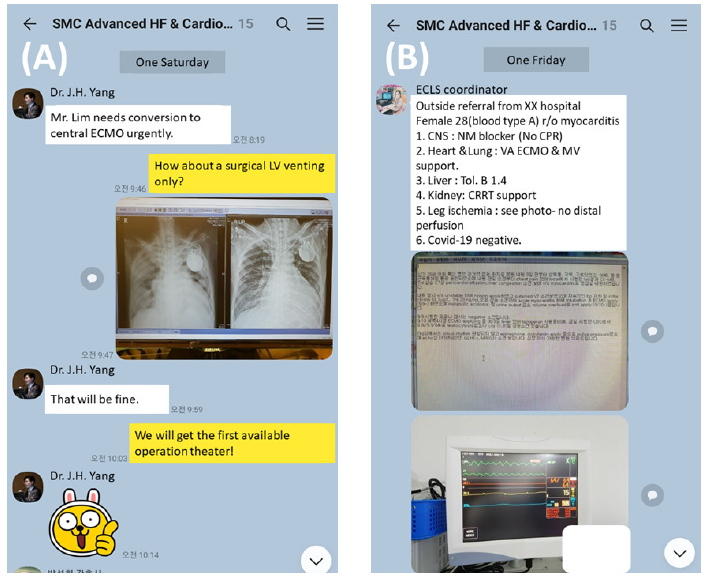
Figure A1. Examples of using a secure online chat room provided by a social network service 400 (KakaoTalk) with 15 participating members in the multidisciplinary team approach at our institu- tion 401 (dates and patient information were blinded, and an English translation is provided). ( A ) A cardiac 402 intensivist (Yang, J.H.) and a cardiac surgeon (Cho, Y.H.) discuss a patient on extra-